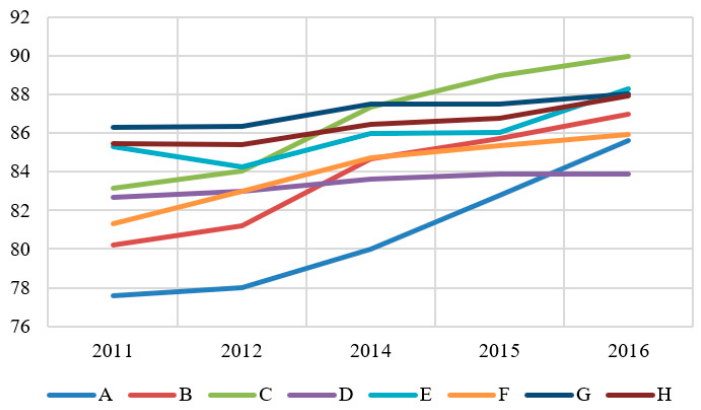
Figure 7. The average value of the using the driver’s working time rate (%) for the analysed